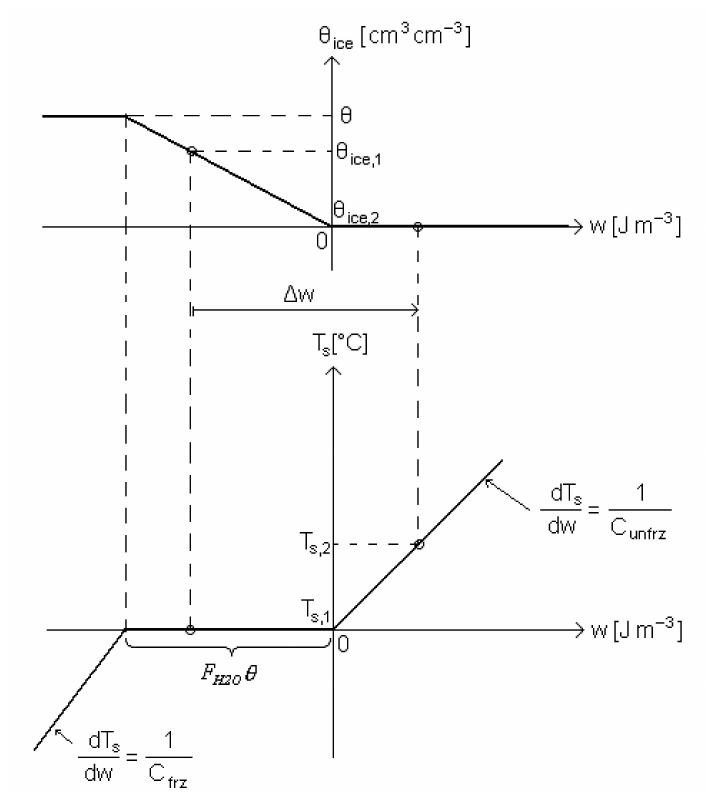
Figure 3. Dependence of soil temperature and ice content on heat energy